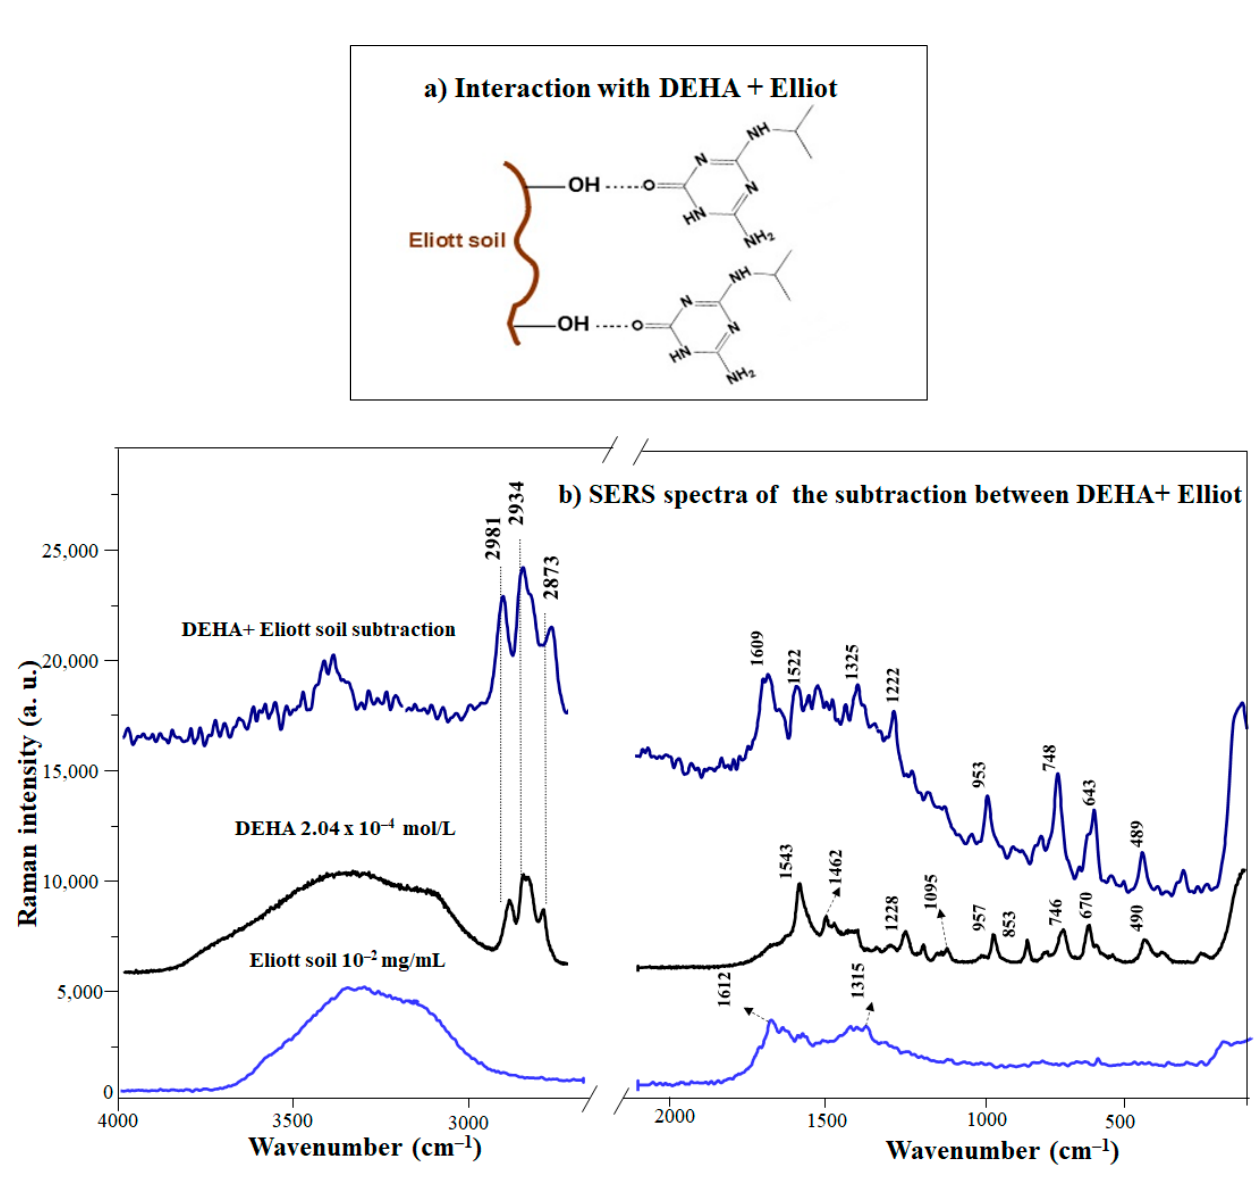
Figure 3. ( a ) Mechanisms of interactions between DEHA in the presence of EHA (1 mg/mL). ( b ) SERS spectrum of the DEHA/EHA complex and non–complexed DEHA.